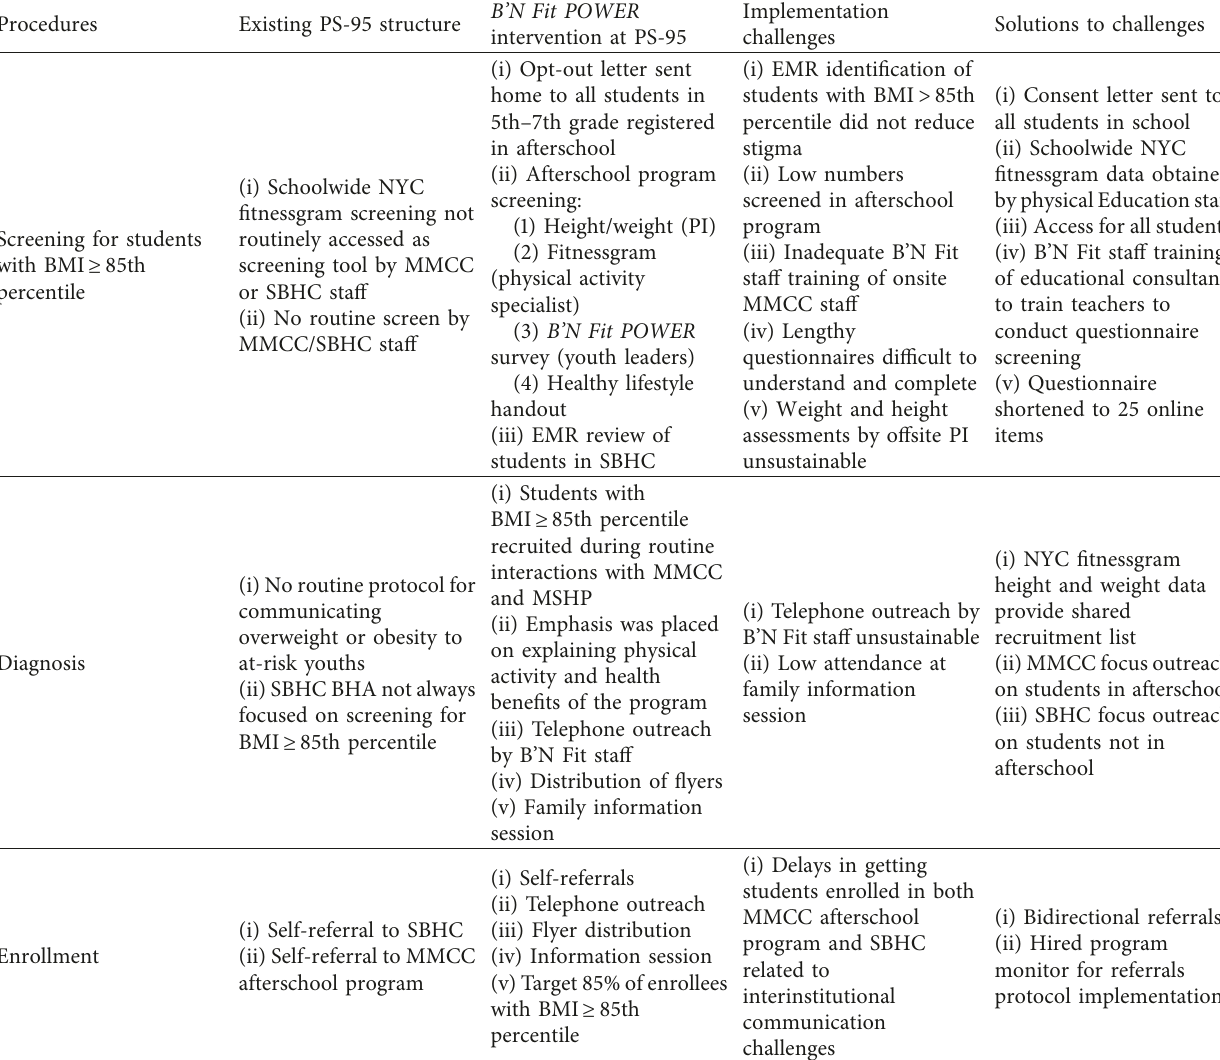
Table 4: B’N Fit POWER integration of screening, diagnosis, and enrollment